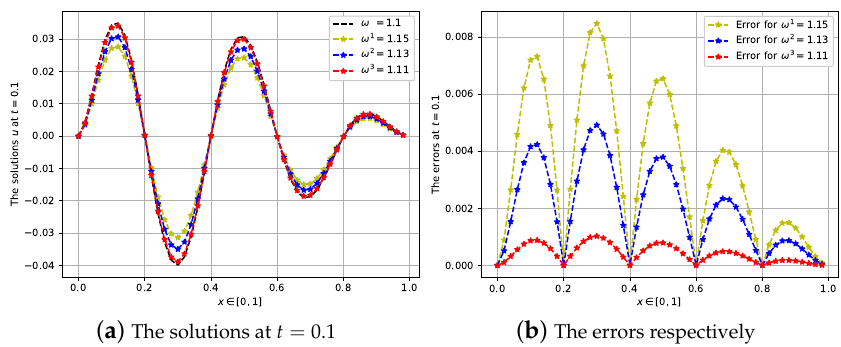
Figure 2. The solution u for ω = 1.1, ω i ∈ { 1.15,1.13,1.11 } at t = 0.1 and the respective error.